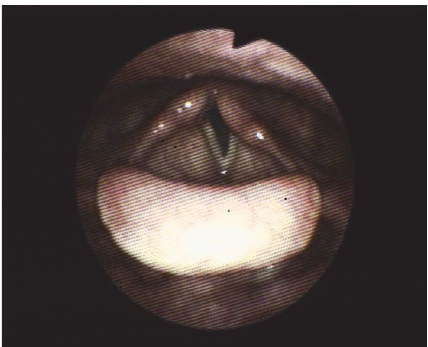
Figure 1: Left vocal cord paralysis during phonation as seen during indirect laryngoscopy, with permission from patient and Dr.